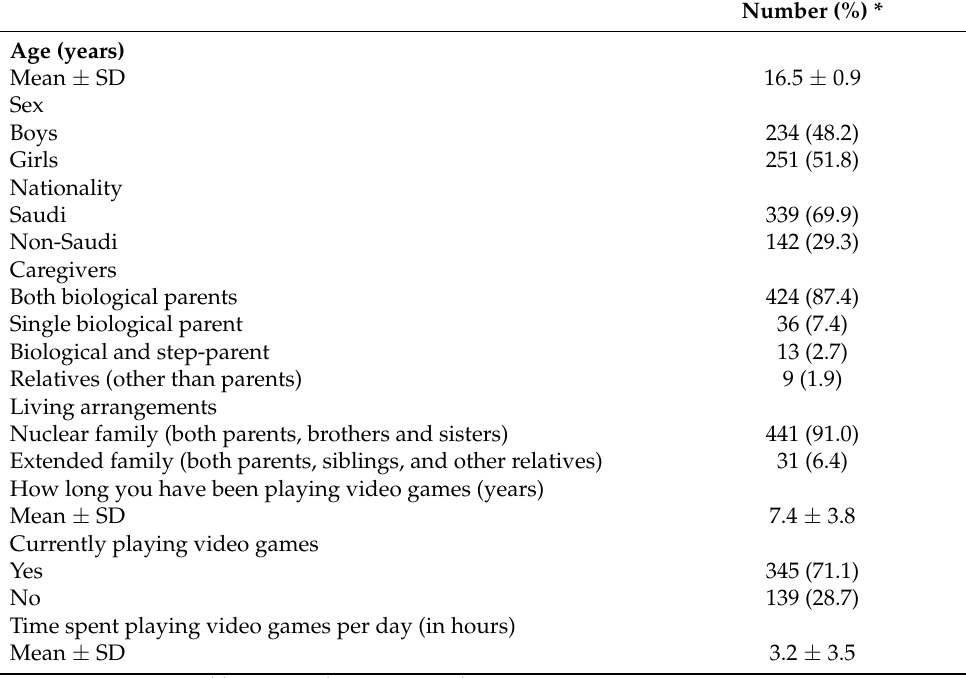
Table 1. Demographic characteristics of participants (N =